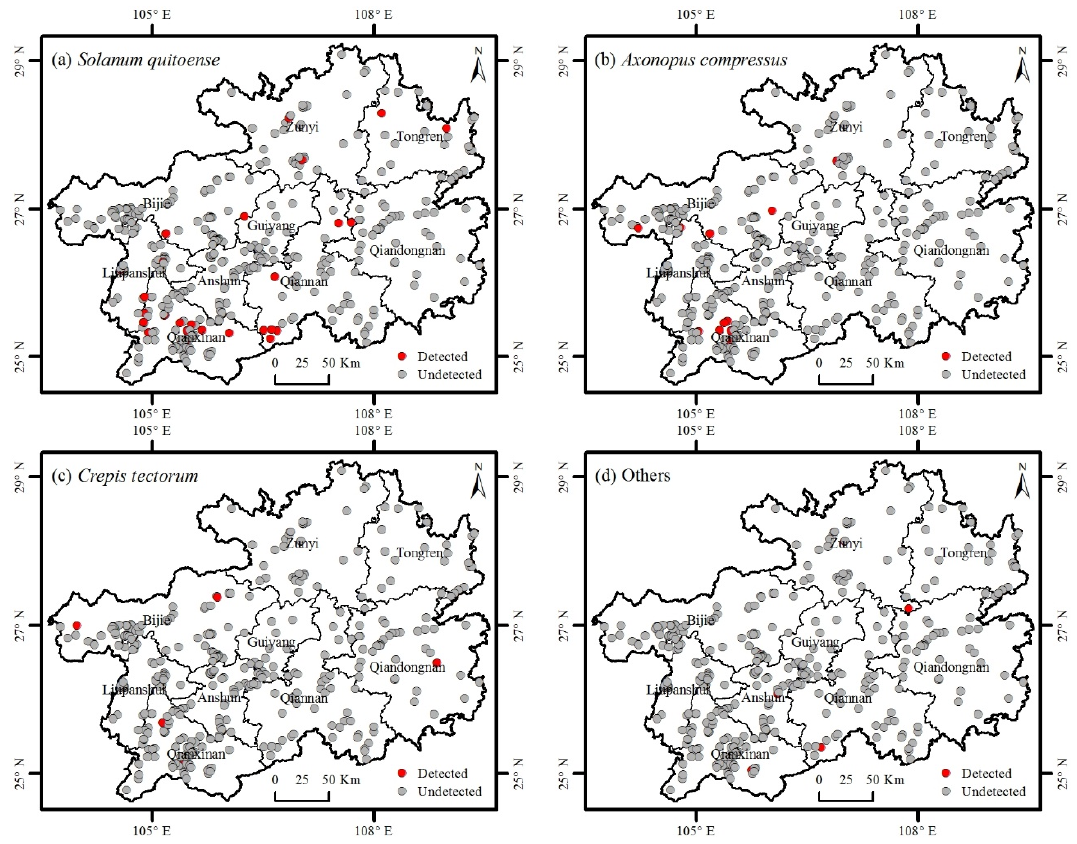
Figure 6. Distribution of invasive plants requiring further investigations (Level 5). Red and grey dots indicate detected and undetected invasive species, respectively. Table 3. Pearson’s correction coefficients between plant invasion intensity and environmental factors. * indicates significant correlation at the level of